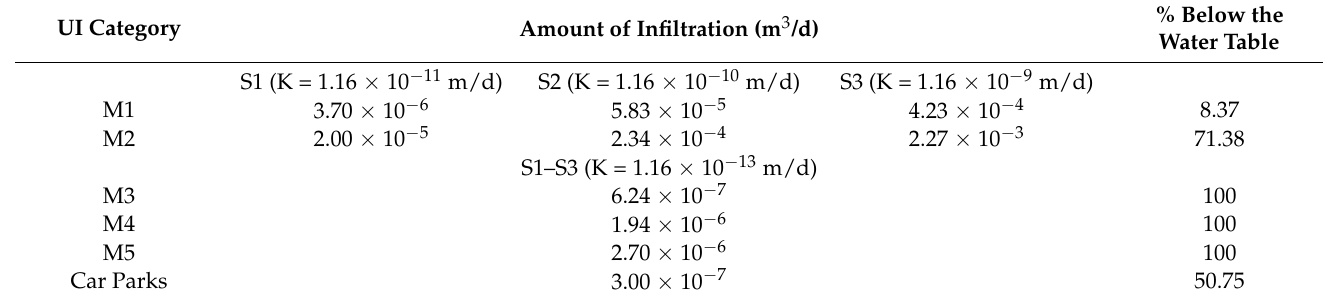
Table 4. GW inflows into UIs (m³/d) for S1 – S3. Please remember that for M3, M4, M5, and parks, K was always set equal to 1.16 × 10 − 3 m/d. Percentage below the water table is intended as the sec- tions of UIs where the bottom of the infrastructure is lower than the hydraulic head.